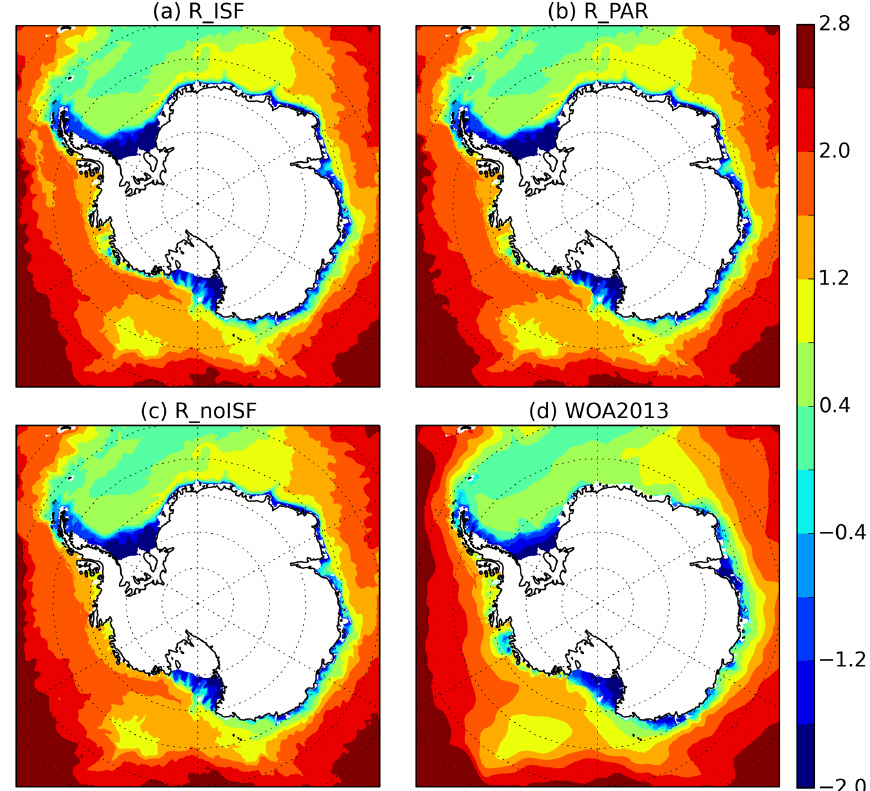
Figure 7. Temperature ( ◦ C) averaged between 300 and 1000m (year 10, 1988) from (a) R_ISF, (b) R_PAR, (c) R_noISF and (d) World Ocean Atlas 2013 (Locarnini et al., 2013; Zweng et al.,